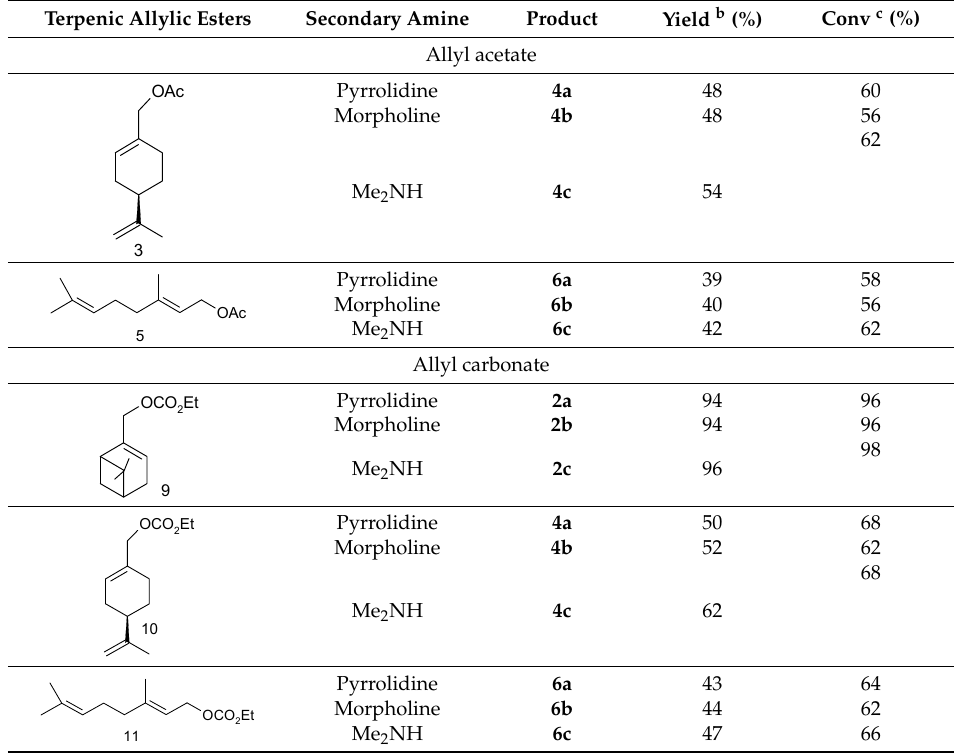
Table 10. Catalytic amination of terpenic allylic esters a . Adapted from [124].